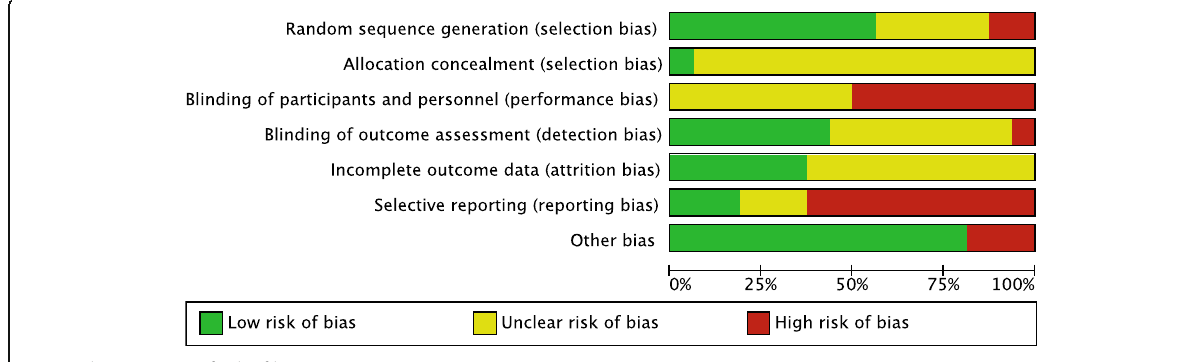
Fig. 8 Characteristics of risk of